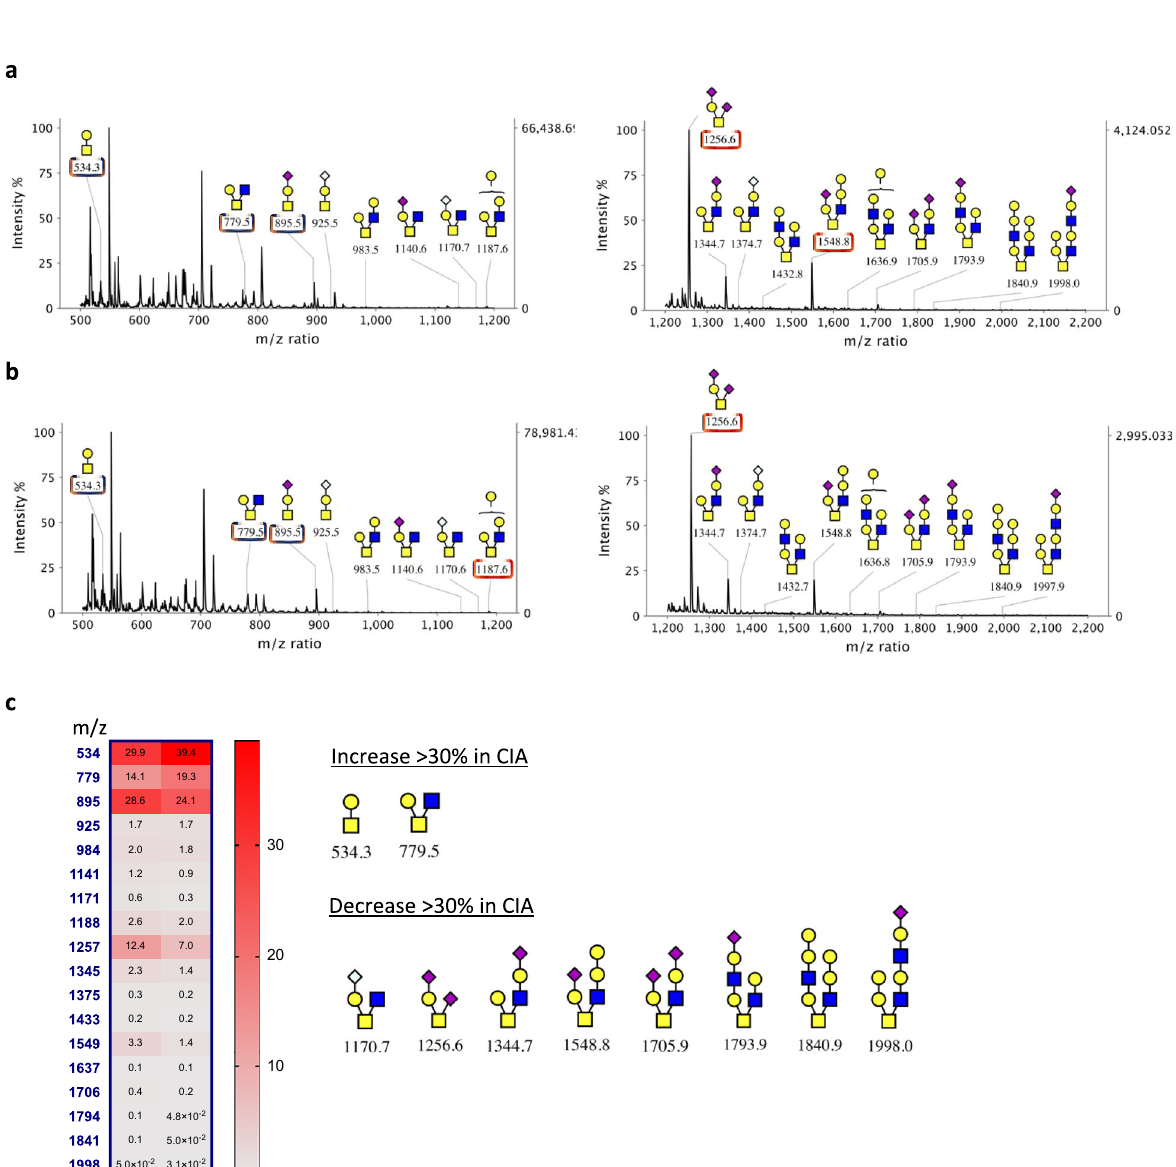
Fig. 2 Synovial fi broblasts from arthritic mice have a reduction in sialylated N-glycans. N-glycans from synovial fi broblasts expanded from healthy or arthritic synovial fi broblasts were isolated and permethylated prior to MALDI-TOF MS analysis. 43 structures were selected (relative expression >0.02%) and MS peak area was quanti fi ed and normalized against total measured intensities. Unsupervised hierarchical clustering with Euclidean distance grouped structures into six main clusters. Structures present in each cluster are shown. Blue and red dots represent SFs isolated from healthy and CIA mice respectively. Data show the results from 4 independent experiments, where healthy and arthritic fi broblasts samples were processed in parallel. Before- after graphs show all structures present in the indicated clusters, where individual dots are the mean of relative expression from 4 experiments and similar structures in healthy and CIA cells are connected with lines. Statistical signi fi cance between healthy and CIA was assessed by one-tail paired t -test, * p < 0.05 and ** p < 0.01. Actual p -values: a 0.0046, b 0.0371, c 0.024. Relative expression for each glycan structure (shown with their m / z value) is also shown in scatter plots showing mean and SEM, where each dot represents the relative expression of one independent experiment, n = 4, * p < 0.05 and ** p < 0.01 using unpaired one-tail t -test. Actual p -values: d 0.0153, e 0.0385, f 0.0372, g 0.0478, h 0.0005, i 0.0420.